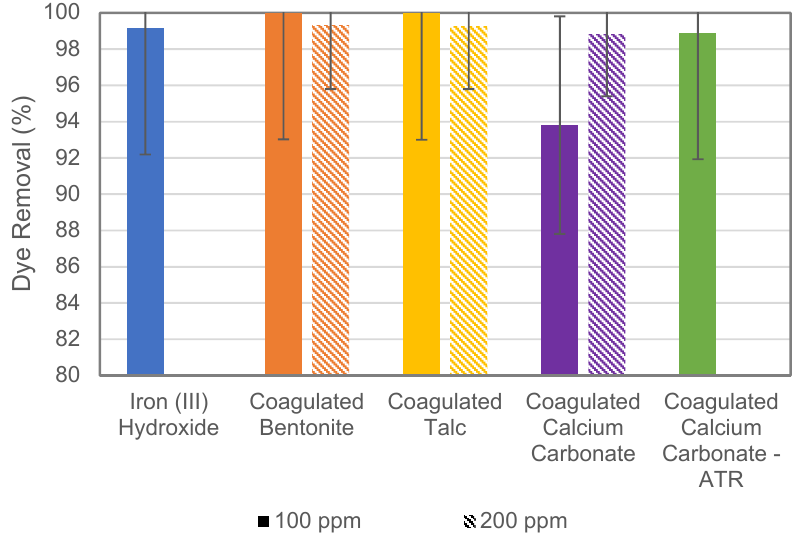
Figure 12. Percentage dye uptake for coagulated modified bentonite, talc and calcium carbonate, in comparison to pure iron hydroxide from batch tests. Moreover, shown is dye uptake for coagulated calcium carbonate from the ATR.